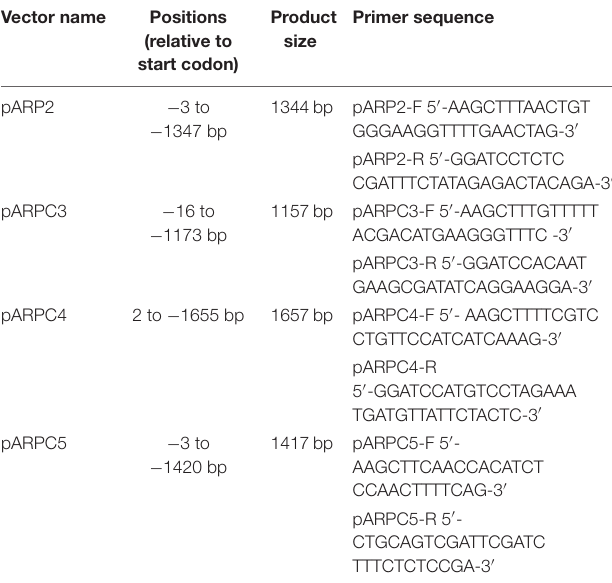
TABLE 1 | List of primers used for promoter activity